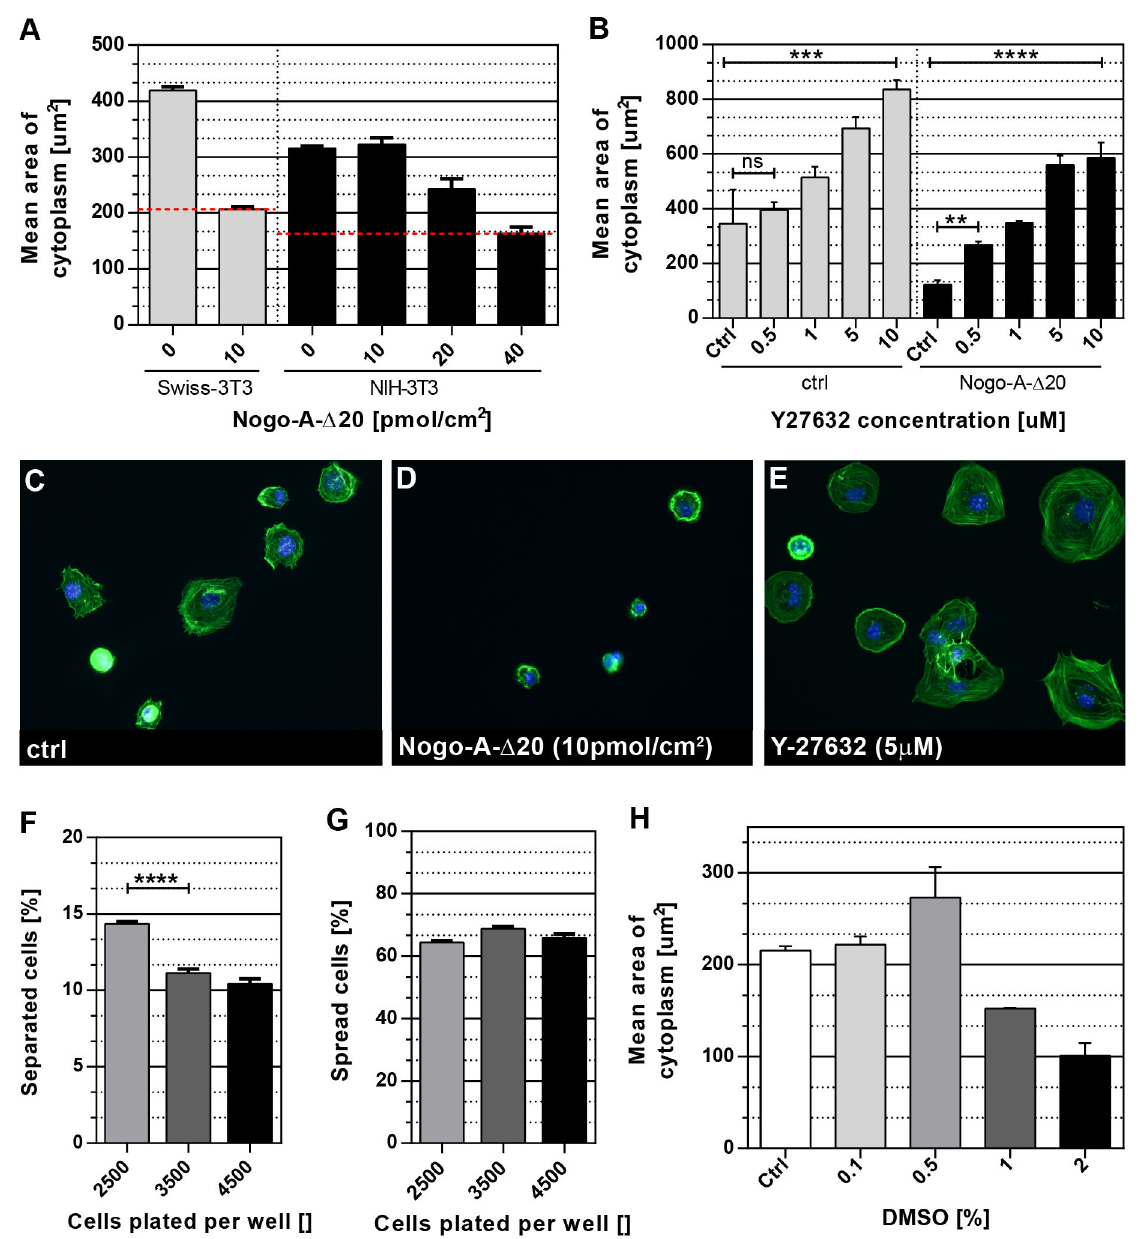
Figure 2. Assay optimization and validation. To ensure assay reliability different cell culture conditions were tested: ( A ) Cell type . Graph shows cell area after one hour of cell spreading on control vs. Nogo-A-Δ20 substrate for two different 3T3 fibroblast lines (red dotted lines mark IC of Nogo-A-Δ20). ( B ) Positive control . ROCK inhibitor (Y-27632) dose-response curve for 3T3 cell 50 spreading on control (plastic) vs. Nogo-A-Δ20 substrate (10 pmol/cm 2 ). ( C/D/E ) Representative pictures of cells incubated with either 0.1% DMSO (ctrl), 10 pmol/cm 2 Nogo-A-Δ20 (inhibitory substrate) or 5μM Y-27632 (positive control). ( F/G ) Cell Number . The amount of imaged, well separated cells (cells without contact to neighboring cells) per total cells plated is shown in (F) while the number of cells characterized as spread per total cells plated is shown in (G). ( H ) DMSO toxicity . A dose-response curve for increasing DMSO concentrations on cell size (cytoplasm area) is plotted. All experiments were performed at least in triplicate (n=3) . For all graphs: standard errors of the means are shown . Statistical analysis was performed in GraphPad Prism 6 using an ordinary One-Way ANOVA test followed by a Tukey multiple comparison test or by using an unpaired Student’s t-test; p-values: ns>0.05; *<0.05, **<0.005, ***<0.0005, ****<0.00005 .